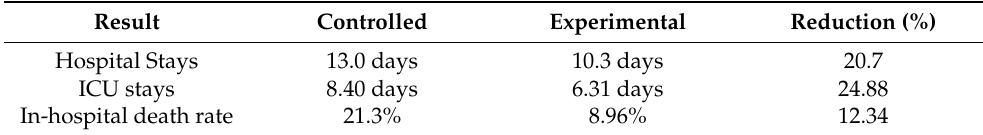
Table 3. Summary of sepsis severity prediction study in terms of stay length and mortality rate.